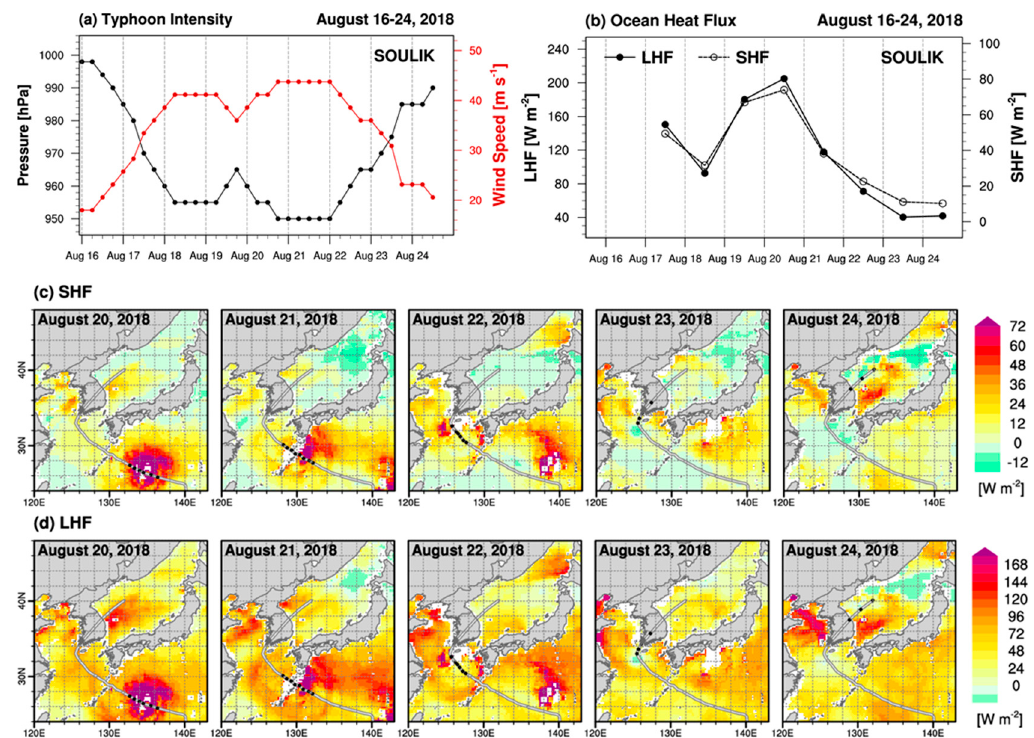
Figure 8. Time series of ( a ) typhoon intensity (central pressure and wind speed) and ( b ) LHF and SHF, which are averaged for the area within 2° of the center; and spatial distribution of daily mean ( c ) LHF and ( d ) SHF during typhoon Soulik, 2018. Gray lines are typhoon trajectory.